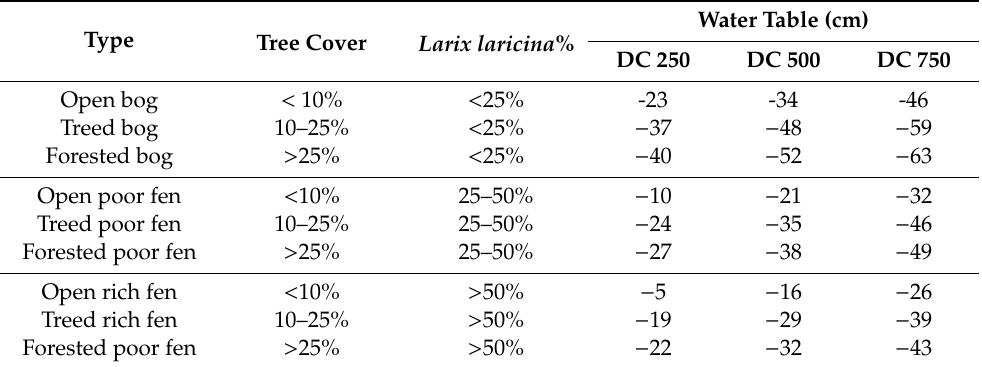
Table A1. Nominal properties of peatland types used in the peatland map. Water table values are estimates from the ANCOVA model (Table A2) and are relative to the average surface level. Negative values indicate water table below the ground surface.